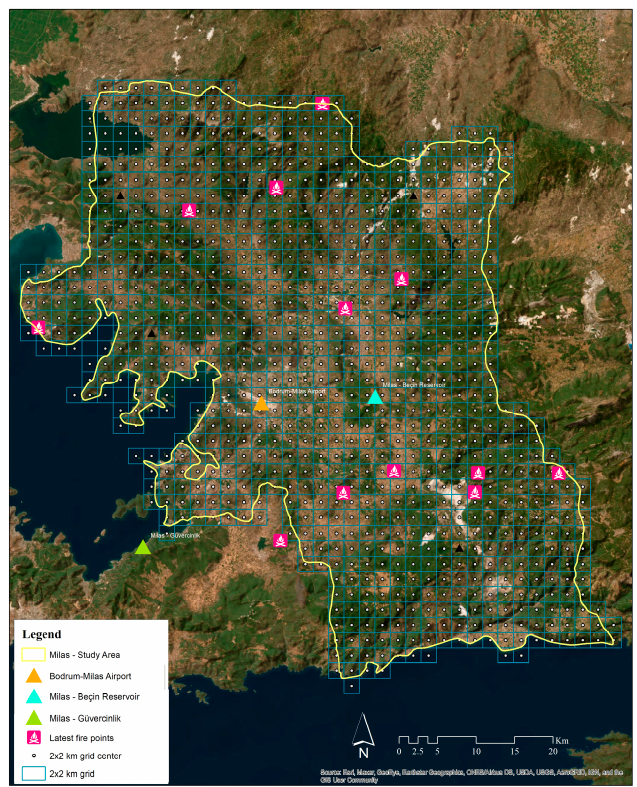
Figure 10. Locations of existing airport/heliports and forest fi res in 2021.